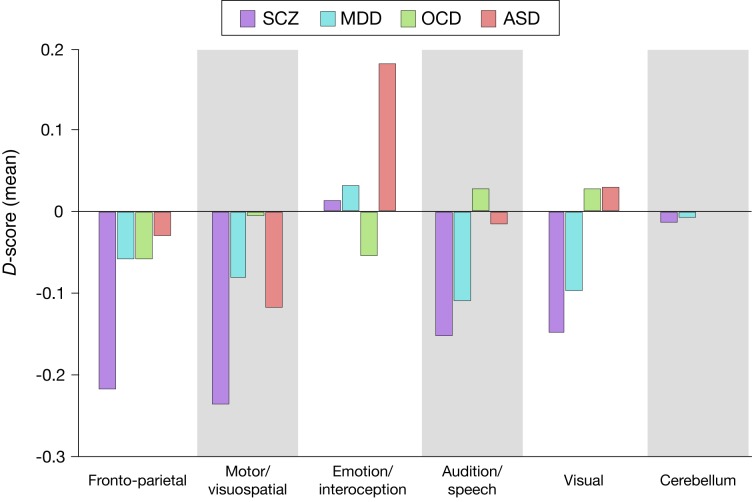
D-scores related to network clusters.